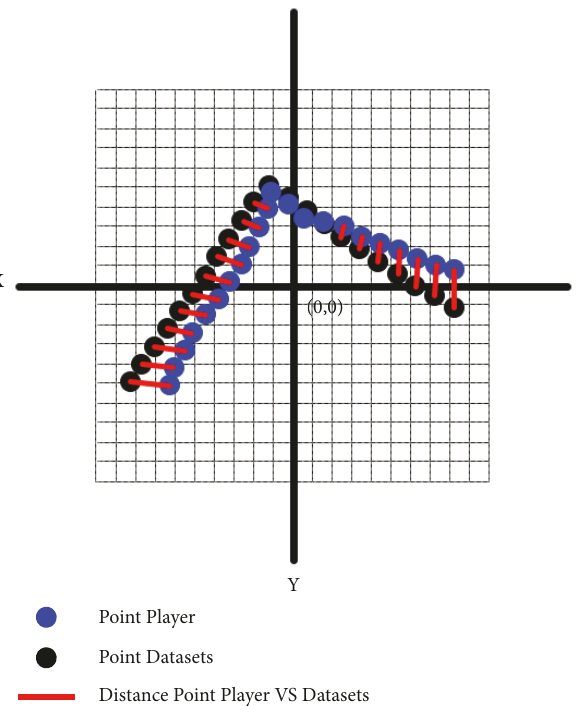
Figure 7: Translation Stages.